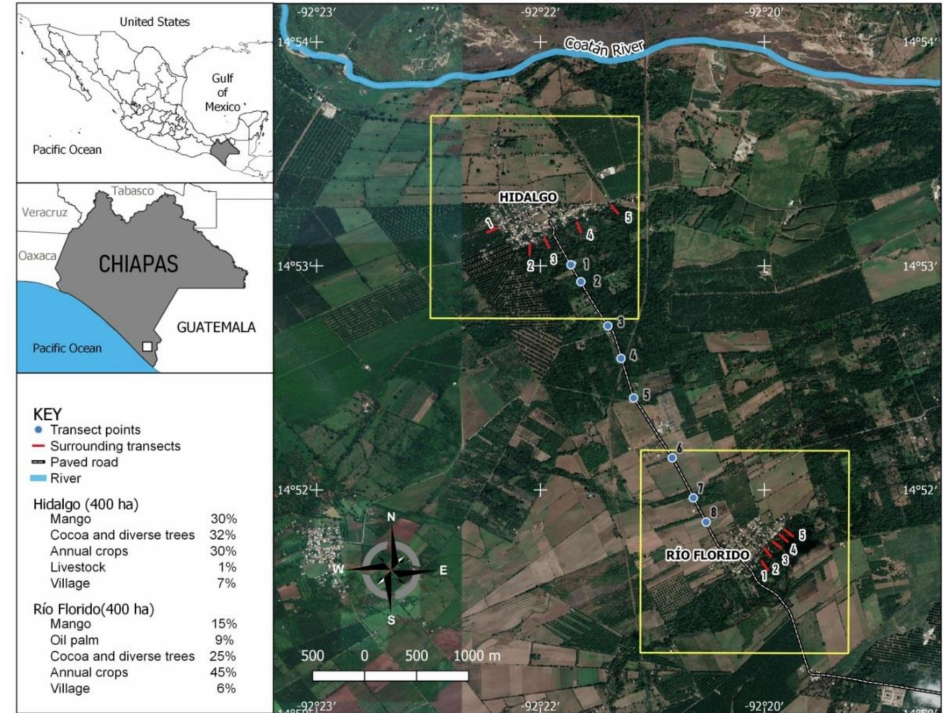
Figure 1. Location of the Hidalgo and R í o Florido study villages in Tapachula municipality, Chiapas State, southern